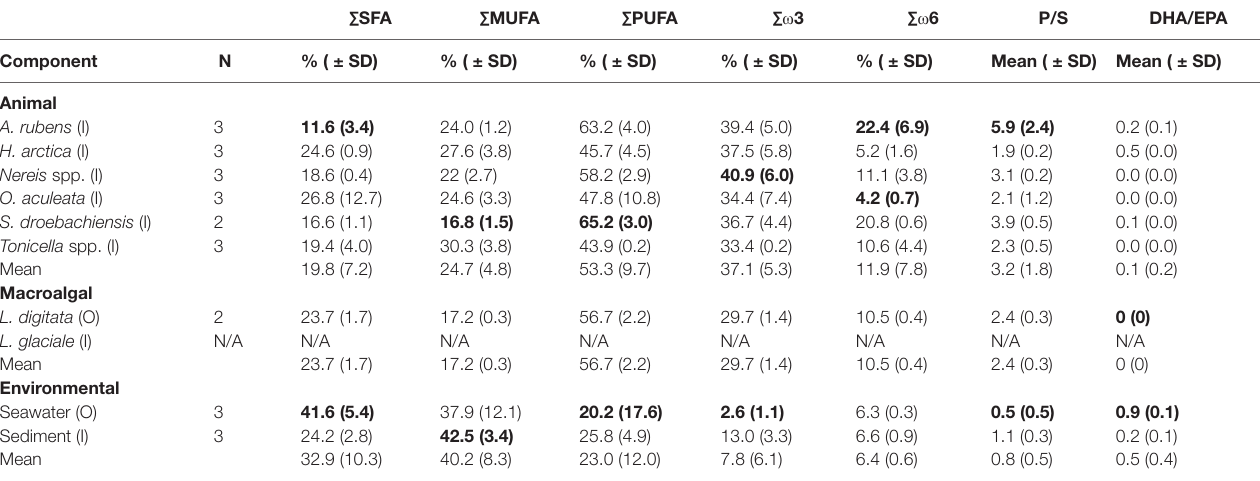
TABLE 3 | Sample size (N), mean proportional sum ( Σ ) of saturated (SFA), monounsaturated (MUFA), polyunsaturated (PUFA), ω 3 (omega-3), and ω 6 (omega-6) fatty acids, and mean ratios of polyunsaturated:saturated (P/S) and DHA EPA (DHA/EPA), in the six animal species, two macroalgal species, and two environmental components (see Table 1 for species list) sampled inside (I) or outside (O) of the South site (see Figure 1A ).